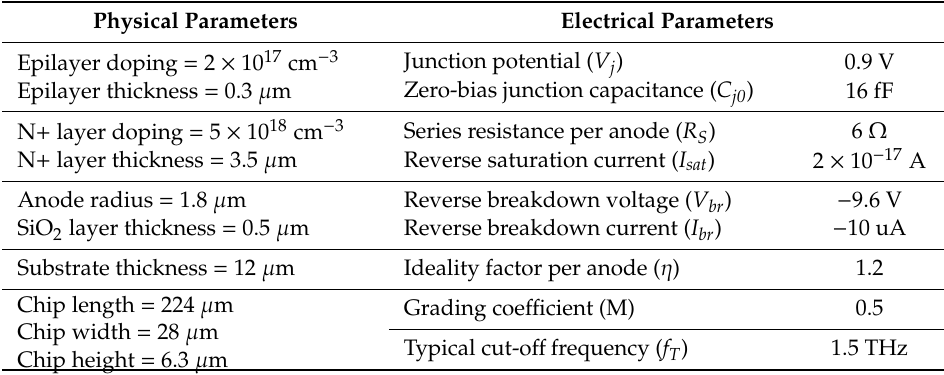
Table 1. Physical and electrical diode parameters of the 0.34 terahertz (THz) tripler.